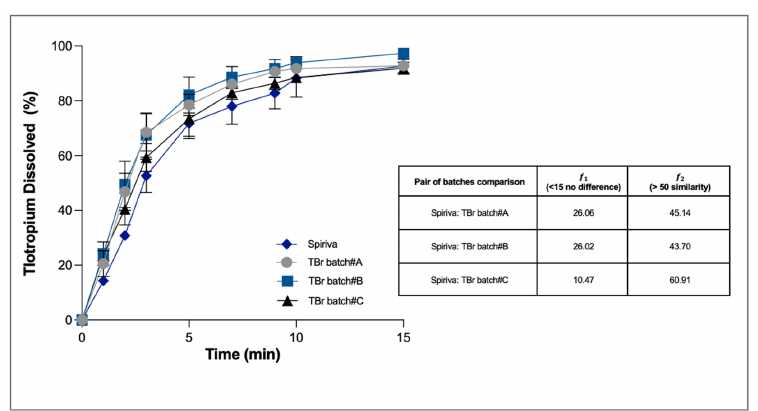
Figure 5. Cumulative mass (%) dissolution profiles of reference product Spiriva (18 µg blended in 5.5 mg of powder) and tiotropium test formulation blends after aerosolisation ( n = 3, mean ± SD). Difference ( f 1) and similarity factor ( f 2) were calculated taking the Spiriva as reference.